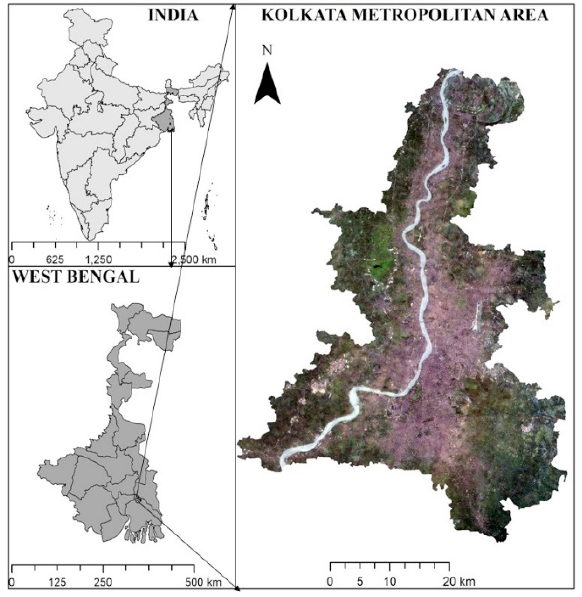
Figure 1 . Location map of KMA